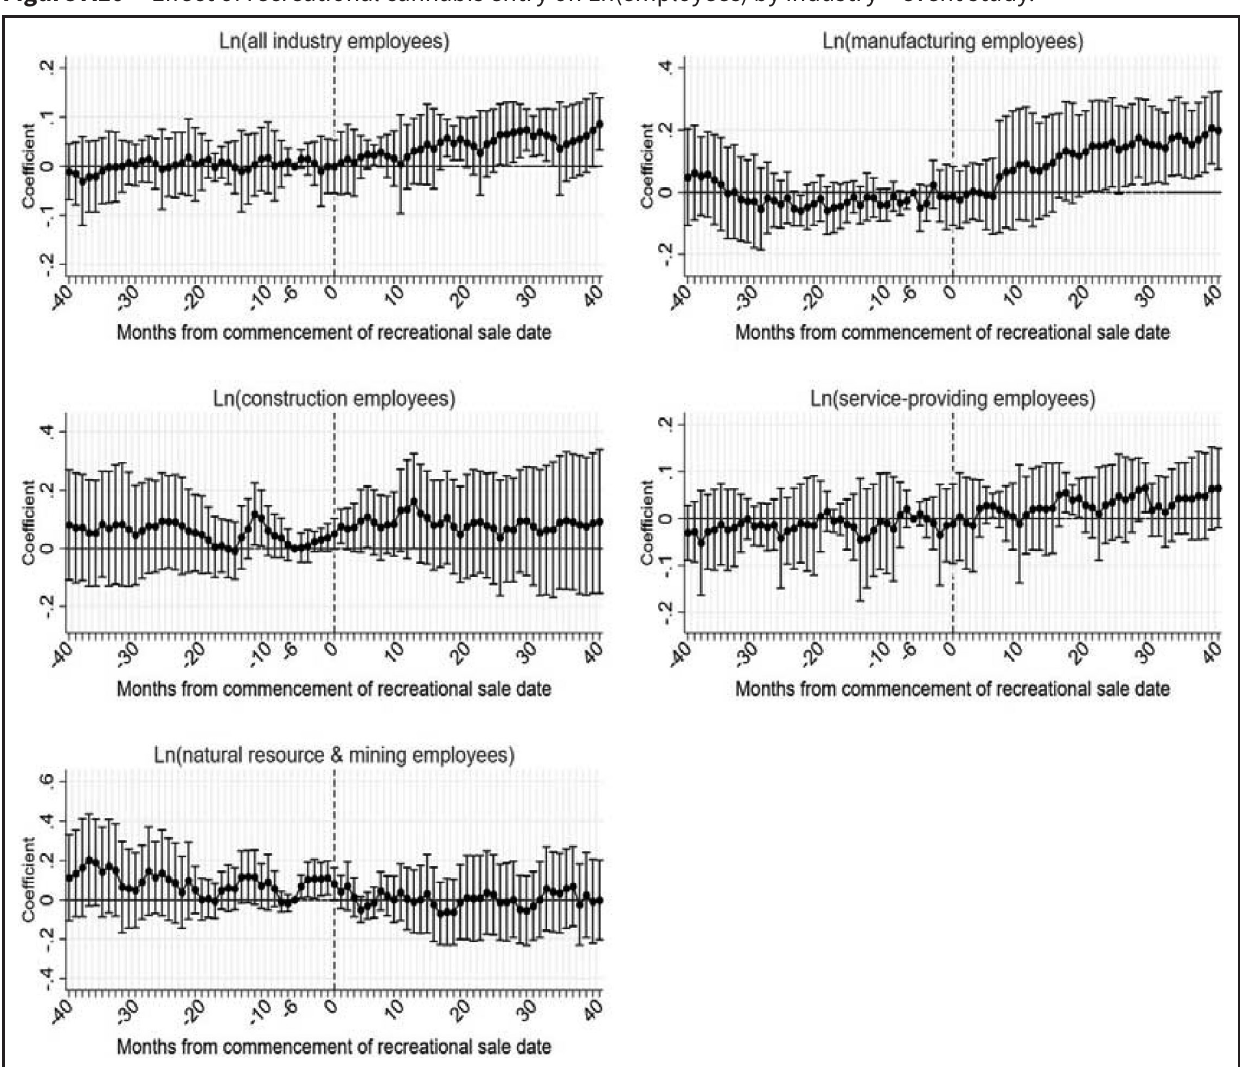
Effect of recreational cannabis entry on Ln(employees) by industry – event